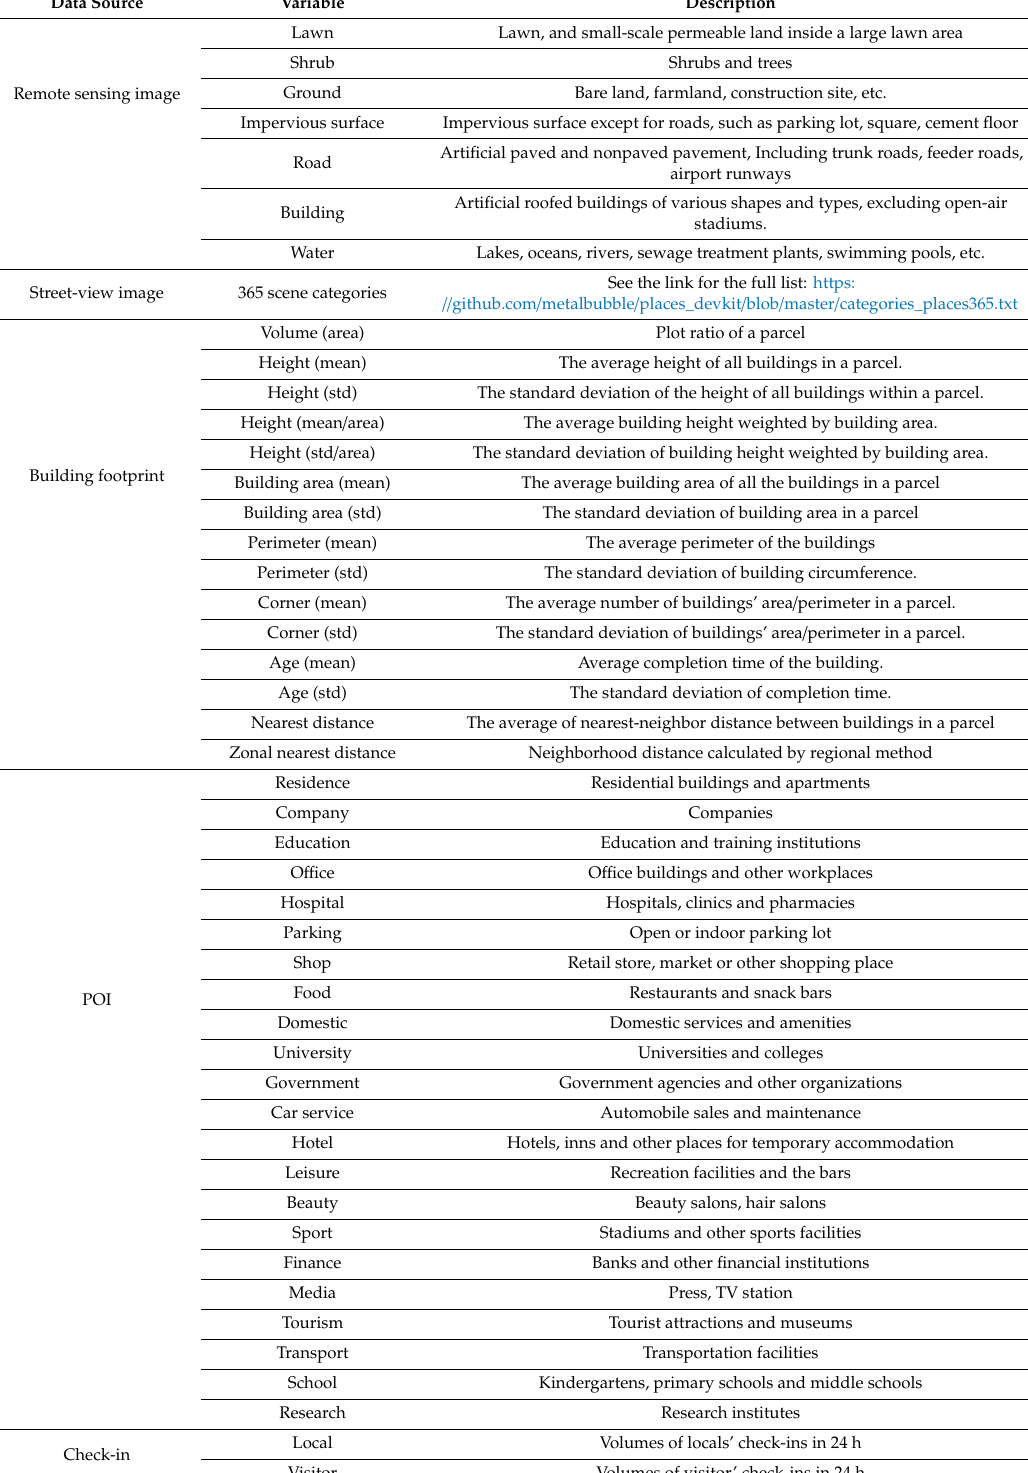
Table A1. List of urban features derived from remote and social sensing